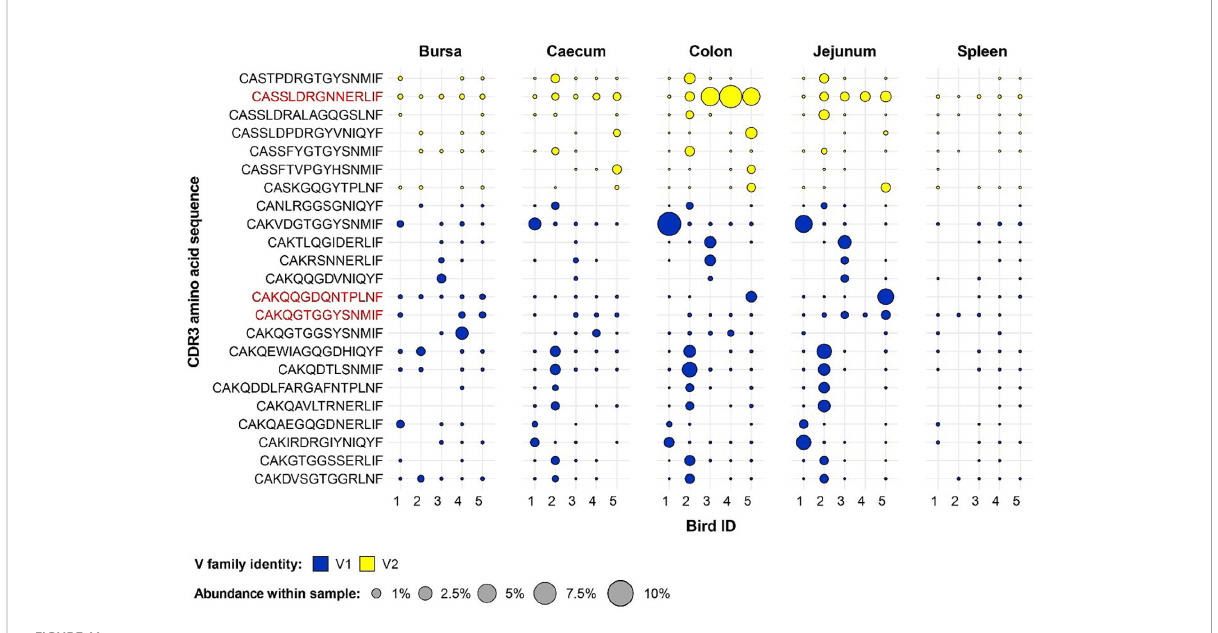
FIGURE 11 Clonal expansions in the restricted repertoire of conventional birds. Circles indicate the presence of clones with a speci fi c CDR3 amino acid sequence and are proportional to the abundance within each bird ’ s tissue clonal compartment. The plot shows only the clones which are preferentially expanded in the conventional birds (at or above 0.5% and at less than 0.5% in the germ-free). Colours indicate V family identity: blue – V1 and yellow – V2. CDR3 amino acid sequences which are expanded in multiple birds are shown in